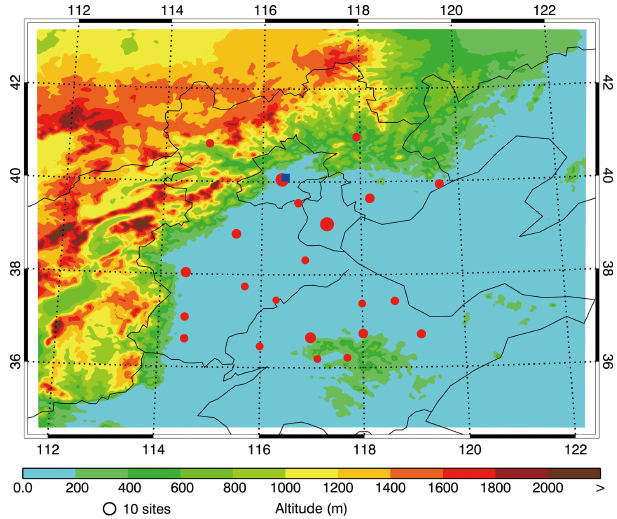
Figure 1. WRF-CHEM model simulation domain with topography. The blue square denotes the location of the Institute of Remote Sensing and Digital Earth (the IRSDE site) in Beijing. The red dots denote the centers of 22 cities throughout BTH that have ambient monitoring sites, and the sizes of the circles denote the number of ambient monitoring sites in the